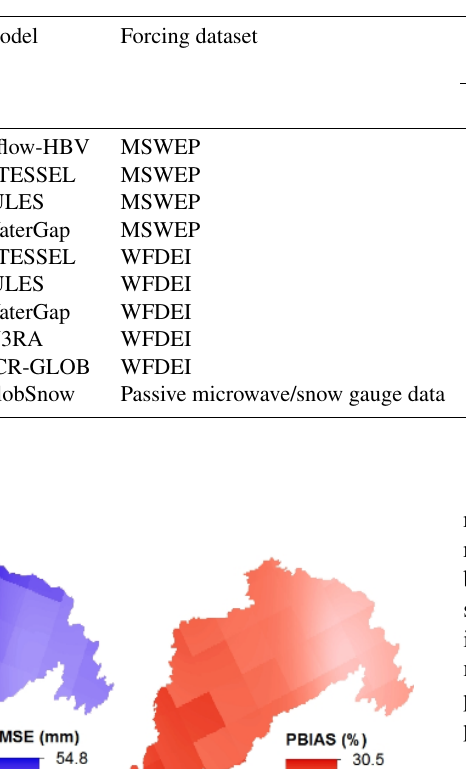
Figure 4. GlobSnow and Ground SWE Measurement Comparison. Table 4. SWE, snowmelt and peak discharge rank correlation analysis.